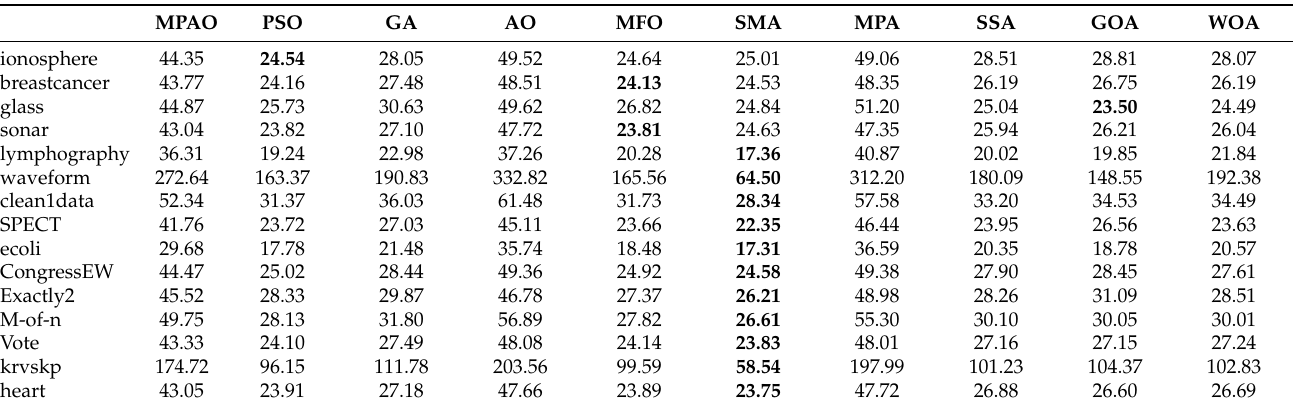
Table 12. Computation time by each algorithm.